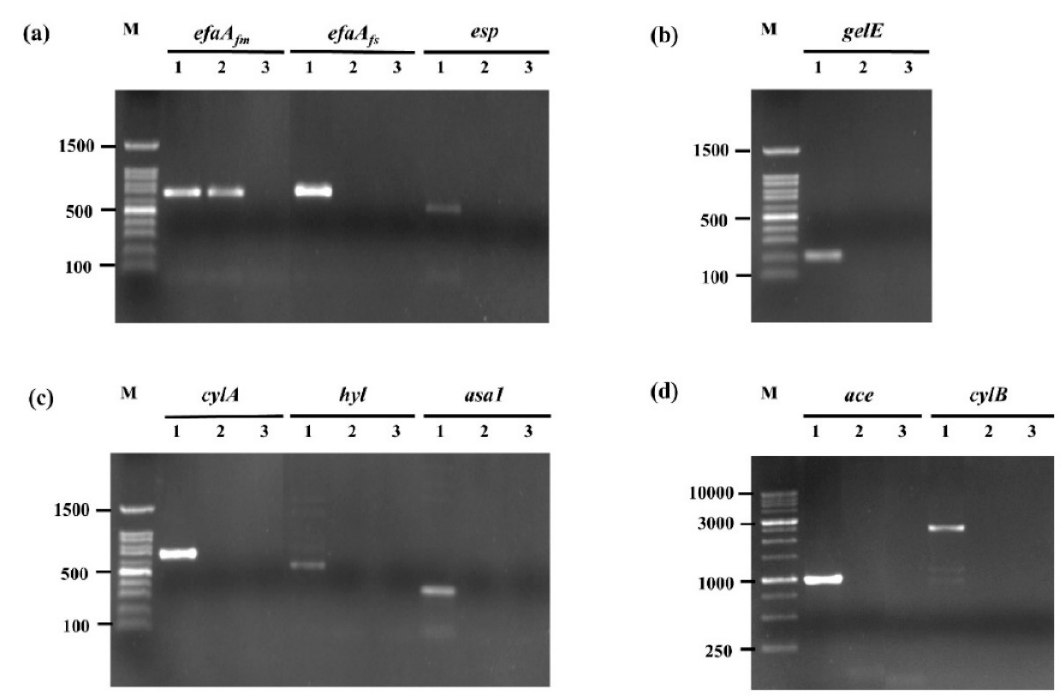
Figure 1. Amplification of virulence gene in E. faecium OV3-6 by PCR. ( a ) efaA fm , efaA fs , and esp genes; ( b ) gelE gene; ( c ) cylA , hyl , and asa1 genes; ( d ) ace and cylB genes; Lane M: 100 bp and 1 Kb DNA markers; Lanes 1: products of positive controls; Lanes 2: products of E. faecium OV3-6; Lanes 3: products of negative controls.